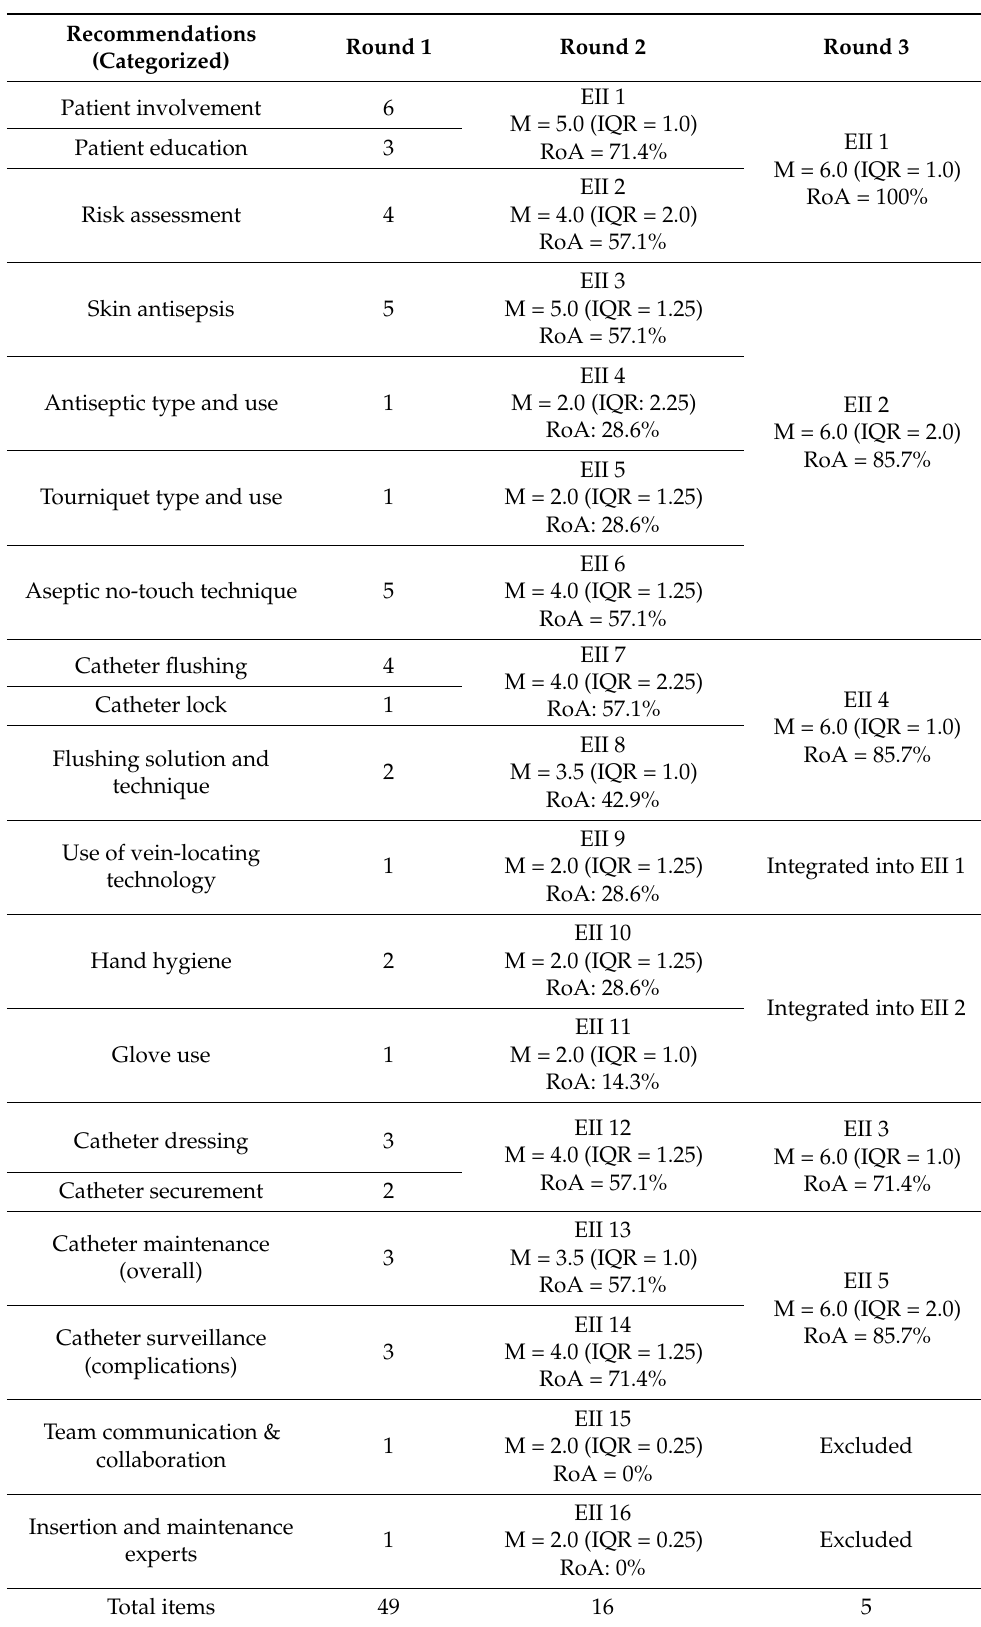
Table 2. Characterization of the Delphi panel